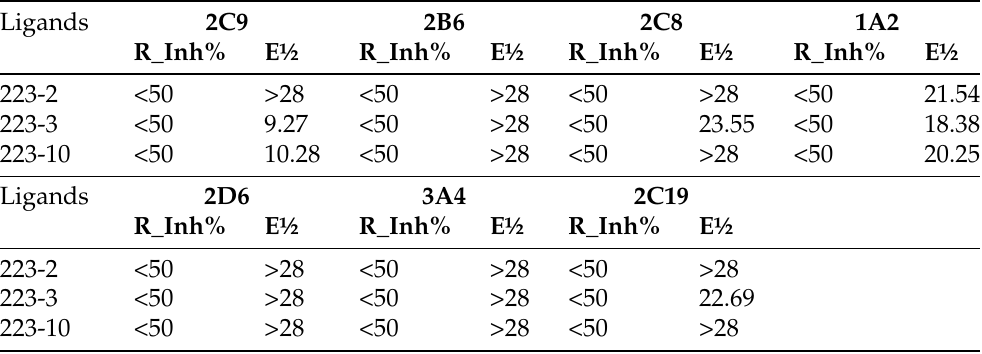
Table 4. Results of TbB ligands by a single K obs assay to assess percent inhibition at a single concentration at thirty minutes (30 min) as single time point. This approach has been utilized to understand the TD inhibition potential of the TbB ligands. The qualified % Reversible Inhibition (R_Inh) %) is considered significant if > 50%. The enzyme inactivation half-life (E½) is used to bin the compounds as positive or negative TD inhibitors if the values are < 28 or > 28,